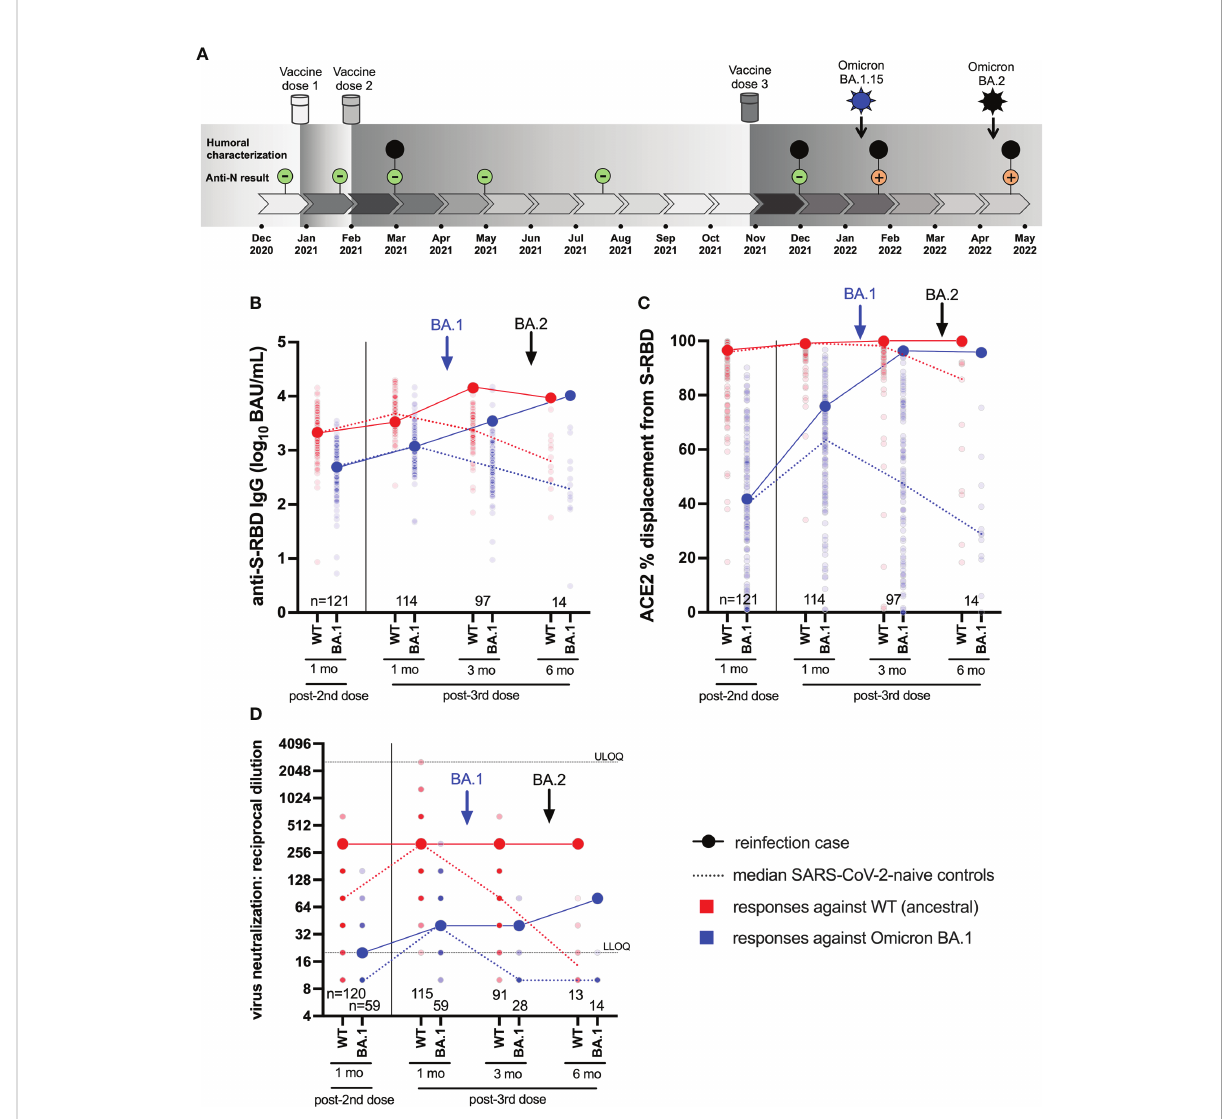
FIGURE 1 Case participant history and longitudinal humoral responses against wild-type and Omicron BA.1 SARS-CoV-2. Panel (A) Case participant timeline. Immunizations and SARS-CoV-2 Omicron infection history are shown at the top. Longitudinal SARS-CoV-2 anti-N serology results are shown in small green (anti-N negative) or orange (anti-N positive) circles. Large black circles denote time points where additional humoral functions, shown in panels below, were measured. Panel (B) Longitudinal anti-S-RBD IgG concentrations, expressed in log 10 BAU/mL, in the case participant (large circles) versus the comparison group of SARS-CoV-2-naive individuals (small circles) at various time points following two- and three-dose COVID-19 vaccination. Wild-type (WT) speci fi c anti-S-RBD responses are shown in red; Omicron BA.1-speci fi c ones are shown in blue. Matching solid lines connect the participant ’ s longitudinal values, while dotted lines connect the median values for the comparison group. Approximate times of BA.1 and BA.2 infections are shown with arrows. Total Ns are shown at the bottom of the plot. Later time points have smaller Ns because some control participants were censored due to post-vaccination SARS-CoV-2 infection or had not yet completed the visit. Panel (C) same as (B) , but for longitudinal ACE2% displacement function from wild-type (red) and BA.1 (blue) S-RBDs. Panel (D) same as (B) , but for longitudinal live virus neutralization function against wild-type (red) and BA.1 (blue) strains. ULOQ/LLOQ: upper/lower limit of quanti fi